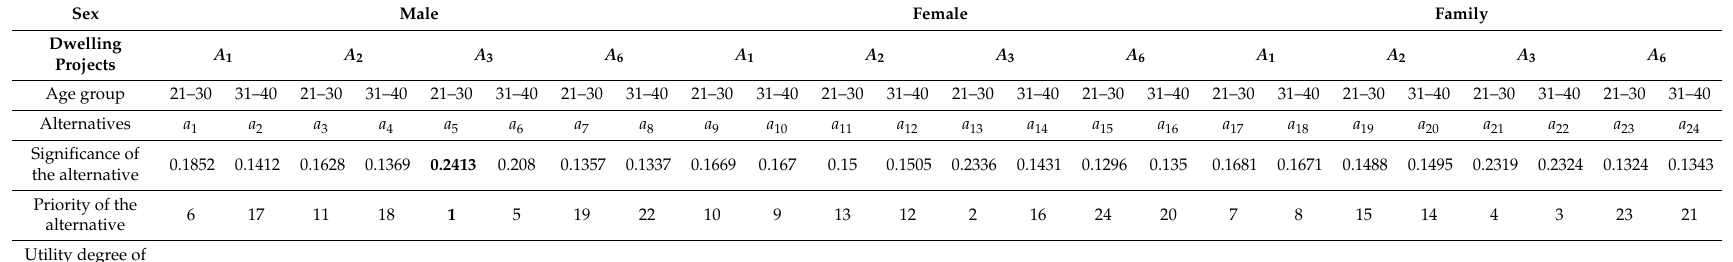
Table 4. Multicriteria evaluation results of the 24 Vilnius City market segments for green and energy e ffi cient residential projects. Sex Male Female Family